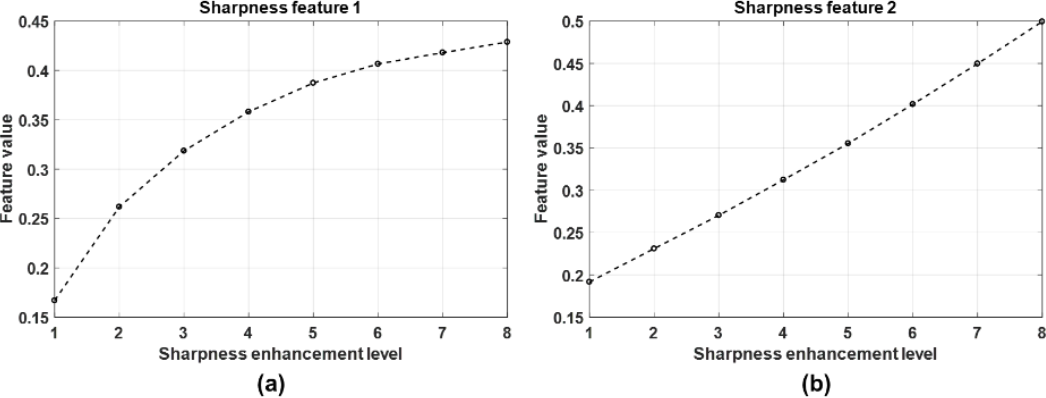
Figure 5. Comparison between the sharpness adjustment level of an image and the calculated sharpness features. Sharpness feature 1 and feature 2 represent the local and global aspects of the colorfulness of the image, respectively.